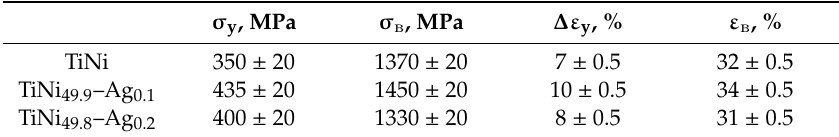
Figure 6. Stress-strain curves of TiNi–Ag wires with different Ag content: 0 ( 1 ), 0.1 ( 2 ), and 0.2 ( 3 ) at.%. Table 2. Mechanical properties of the TiNi–Ag wires.